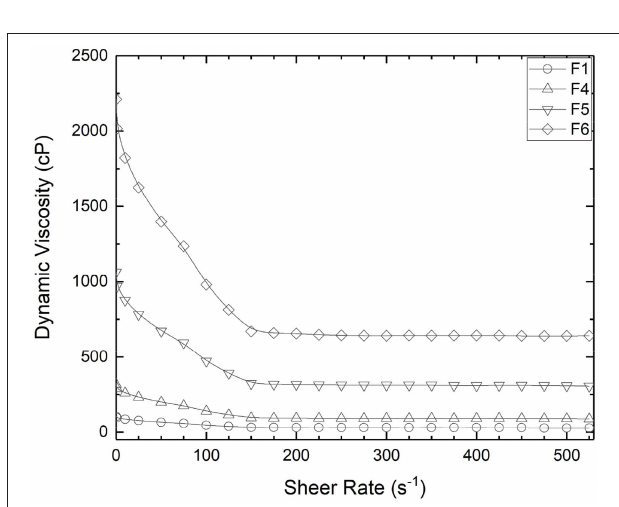
FIGURE 5 | Dynamic Viscosity vs. Shear Rate.